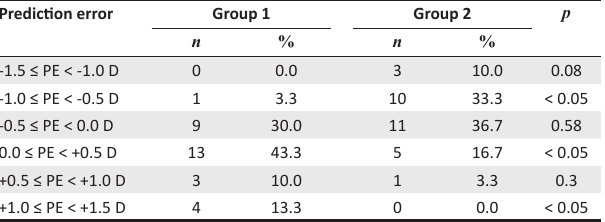
TABLE 4: Deviation of refractive outcome from predicted (target) refraction (numerical